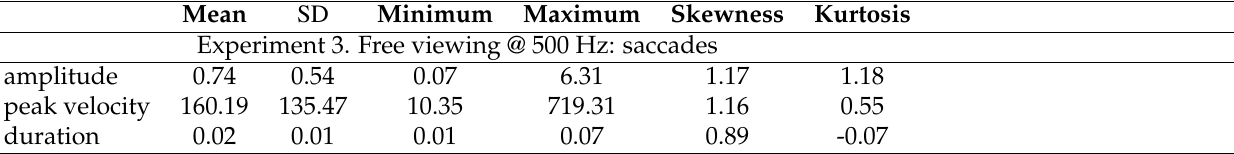
Descriptive statistics of saccade parameters: amplitude (deg), peak velocity (deg/sec) and duration (sec) from Experiment 3. There were N = 89020 in total saccades